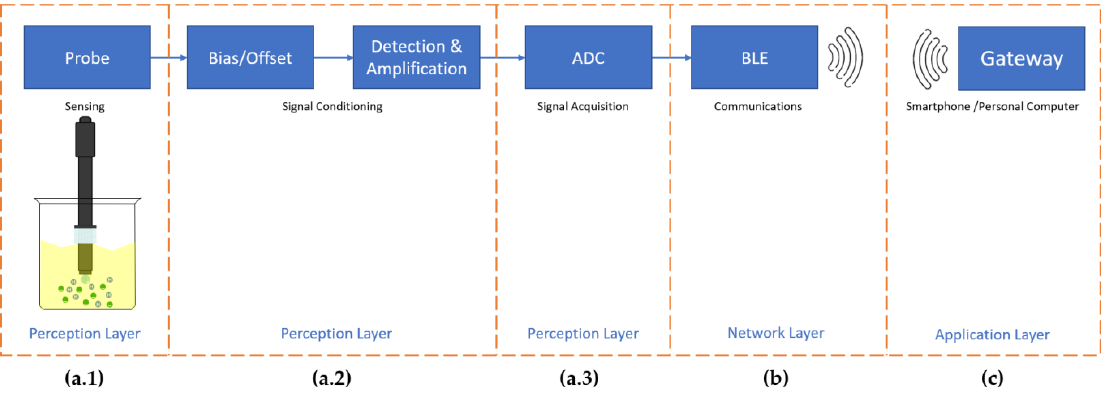
Figure 1. The cost-effective and portable pH instrument has been implemented in a three-layer IoT architecture, consisting of ( a ) Perception , ( b ) Network , and ( c ) Application Layers. The Perception Layer is further divided into: ( a.1 ) Sensing , ( a.2 ) Signal Conditioning, and ( a.3 ) Signal Acquisition stages. The Network Layer has been enabled by means of a Bluetooth (BLE) Communications stage. The Application Layer utilizes a gateway, in the form of a Smartphone or a Personal Computer , for user